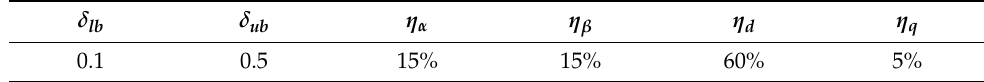
Table 2. User inputs for the adaptive